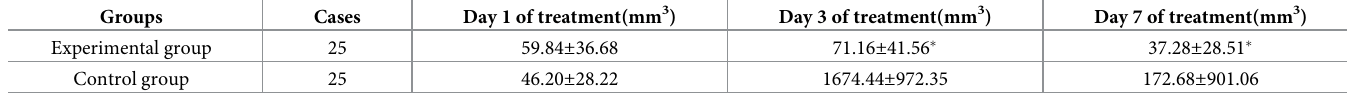
Table 3. Comparison of wound necrosis volume with Cobra bite between two groups of patients. (Mean ± SD).